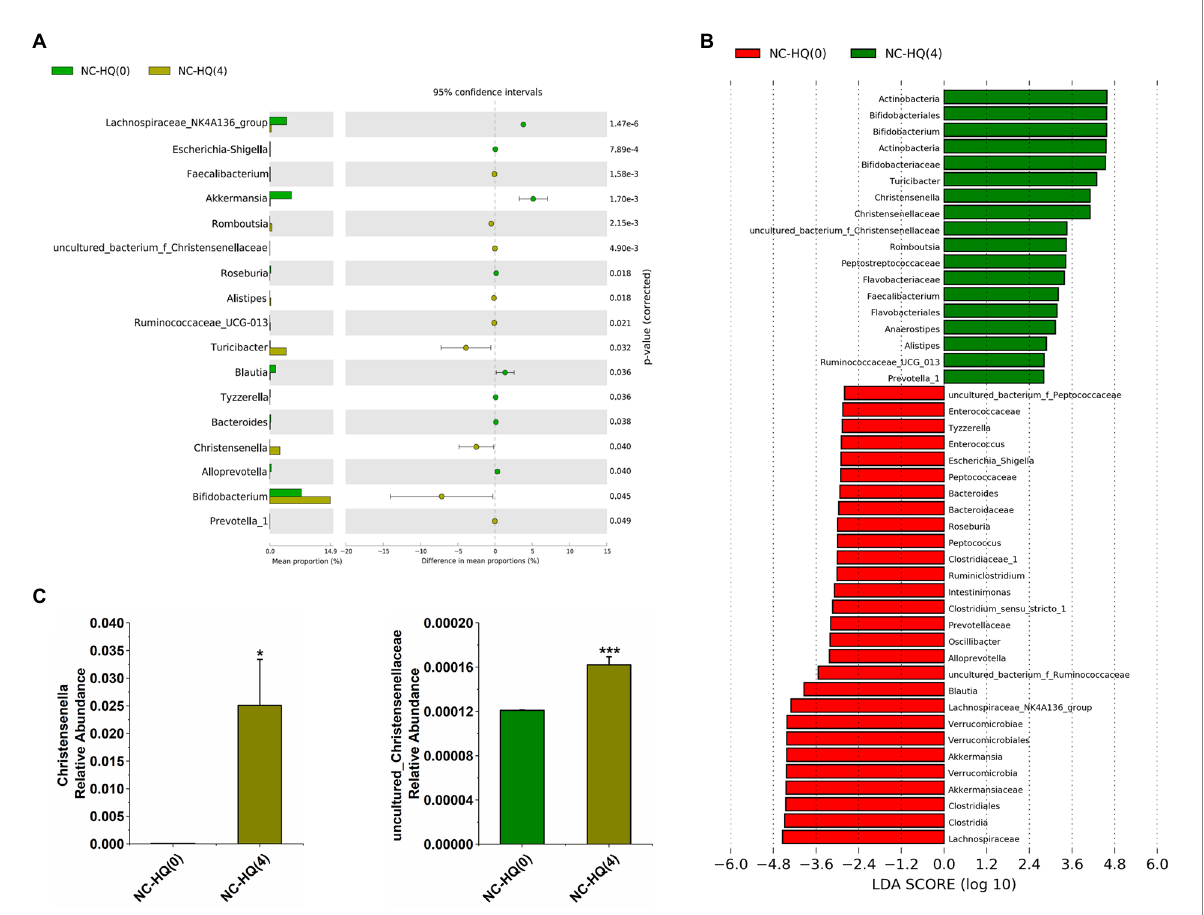
FIGURE 3 (A) Differential abundant features of genus before and after HQLHS treatment. (B) Discriminative taxa determined by LEfSe between the two groups (log 10 LDA > 2.0). (C) Comparison proportion of Christensenella and uncultured_bacterium_f_Christensenellaceae in feces before and after HQLHS treatment. Statistical analysis was performed using Student’s t -test between NC-HQ(0) and NC-HQ (Saeedia et al., 2019) groups. Data are expressed as mean ± SEM. Compare to NC-HQ(0): * p < 0.05; *** p <